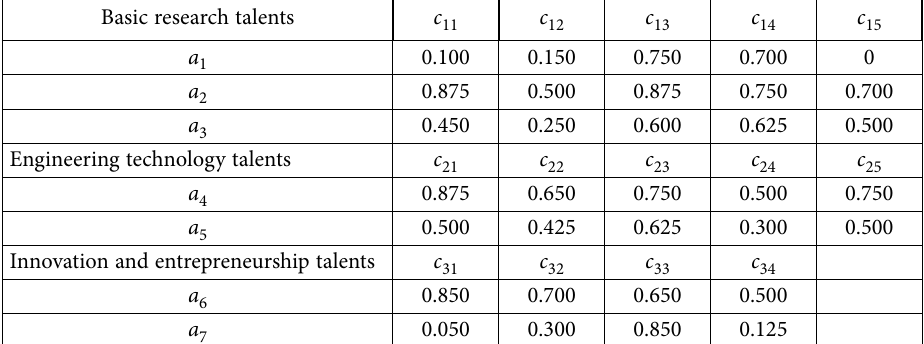
Table 4. The degrees of closeness between the values of alternatives and the aspired values of criteria Basic research